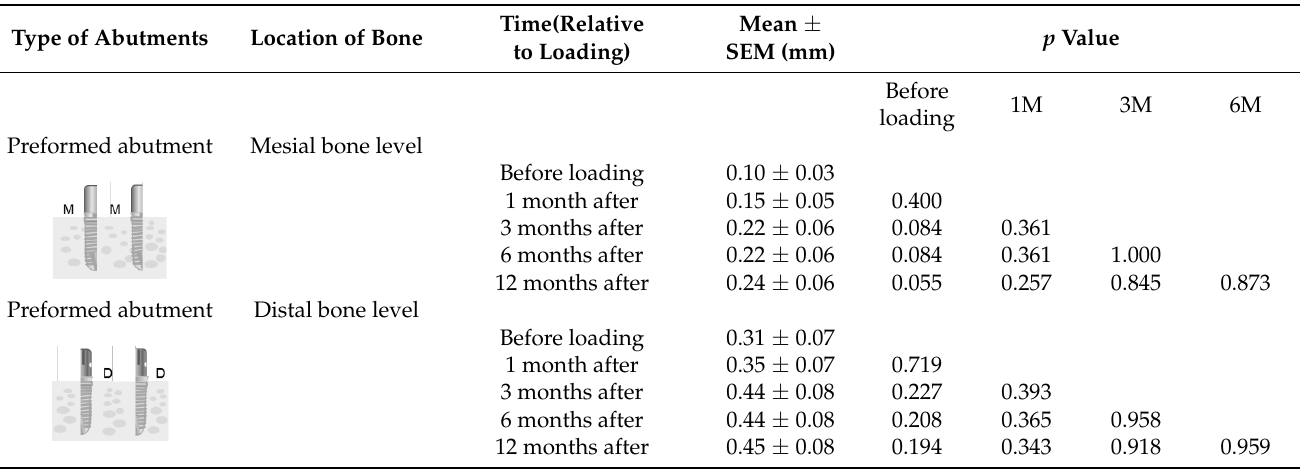
Table 5. Mesial and distal marginal bone levels in the PAs. PA, preformed stock abutment; SEM, standard error of measurement. Type of abut-